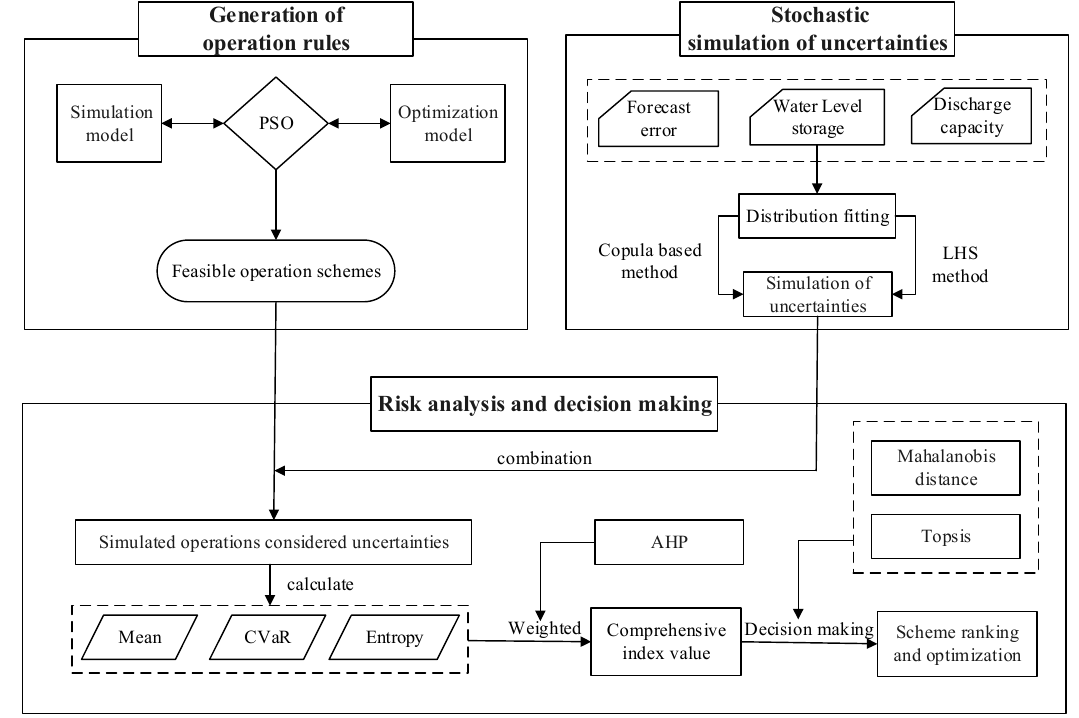
Figure 1. The flow chart of this study. Notes: PSO: Particle swarm optimization, LHS: Latin hypercube sampling, AHP: Analytic hierarchy process, CVaR: Conditional value at risk, TOPSIS: The technique for order preference by similarity to the ideal solution.